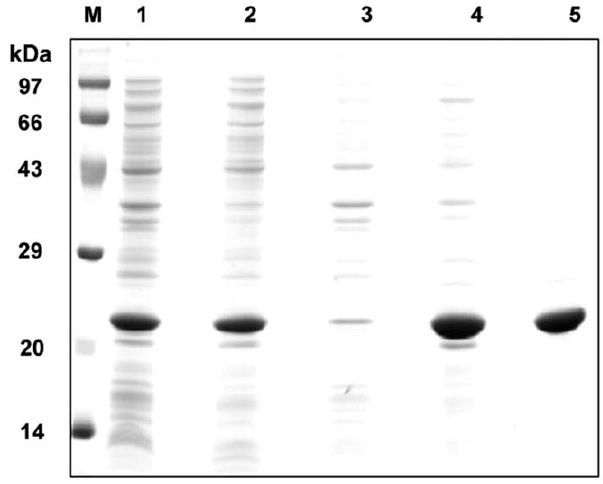
Figure 1. SDS-PAGE pattern showing purification of HspB2 from the soluble fraction of E.coli BL21(DE3) cells over- expressing human HspB2. Lane 1, whole cell lysate; Lane 2, soluble fraction; Lane 3, insoluble fraction; respectively, Lane 4, HspB2 precipitated by 20% saturated ammonium sulfate; and Lane 5, HspB2 purified by Phenyl Sepharose chromatography.